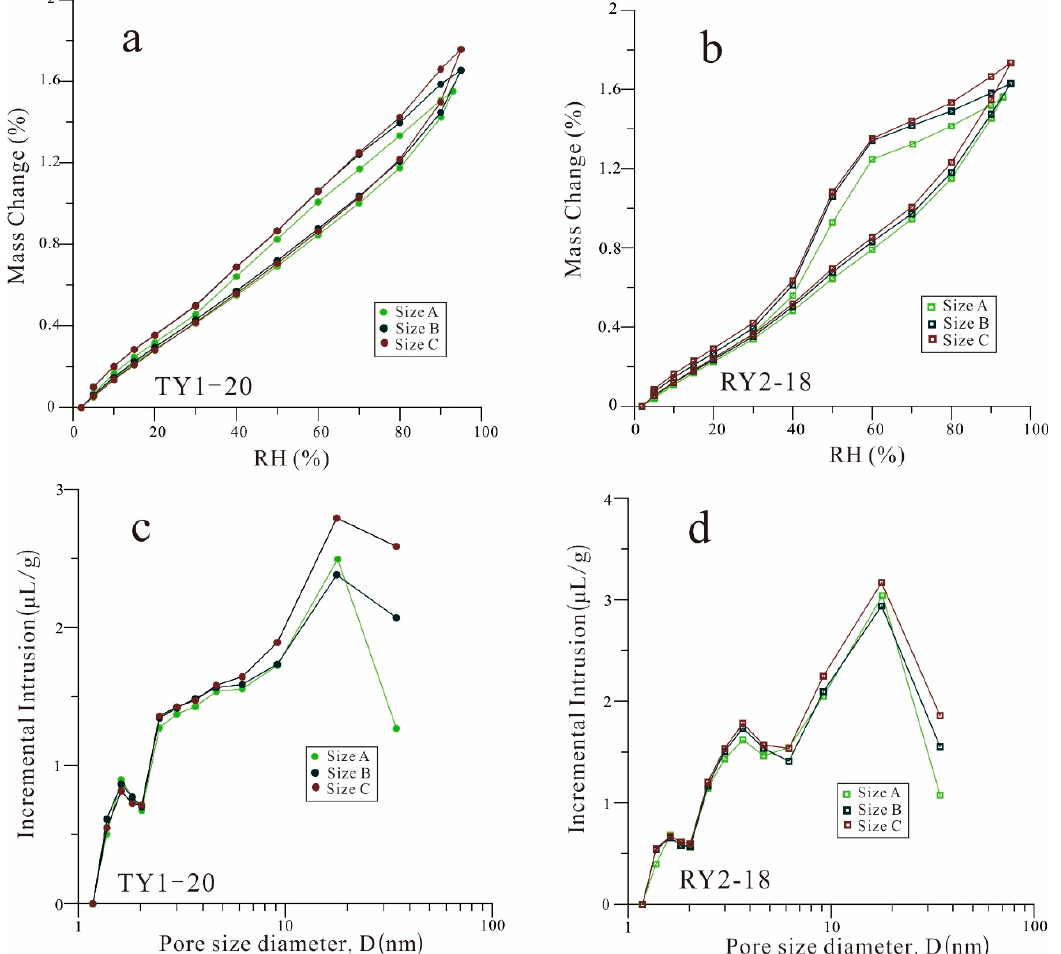
Figure 6. ( a , b ) Water vapor adsorption/desorption isotherms and ( c , d ) PSD for the TY1-20 and RY2-18 samples with three different particle sizes. Table 3. Parameters obtained from water vapor adsorption (WVA) and MICP analyses.